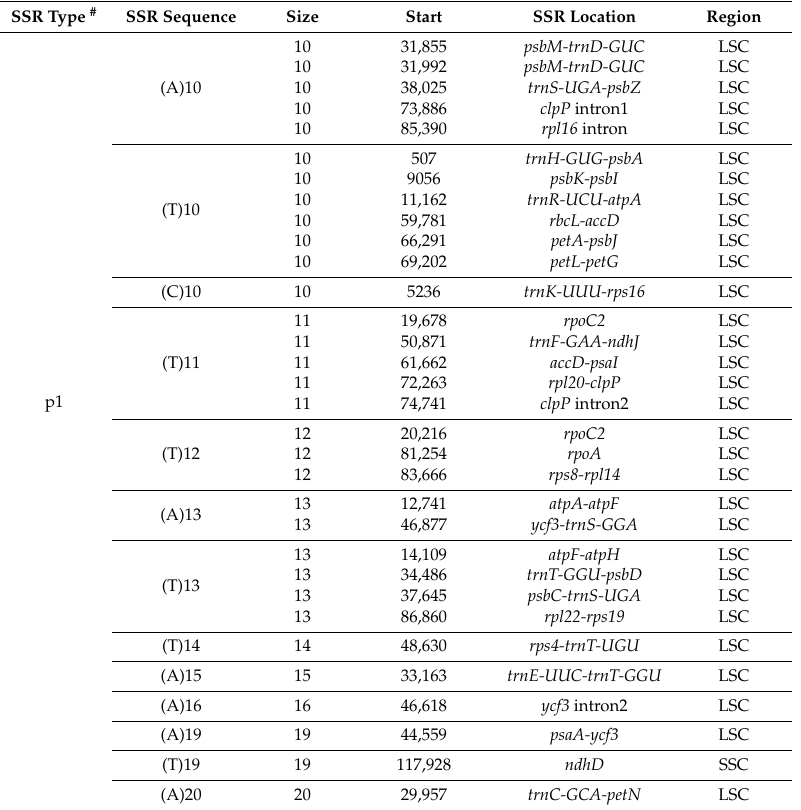
Table 5. Distribution of SSR loci in the chloroplast genome of Forsythia suspensa .